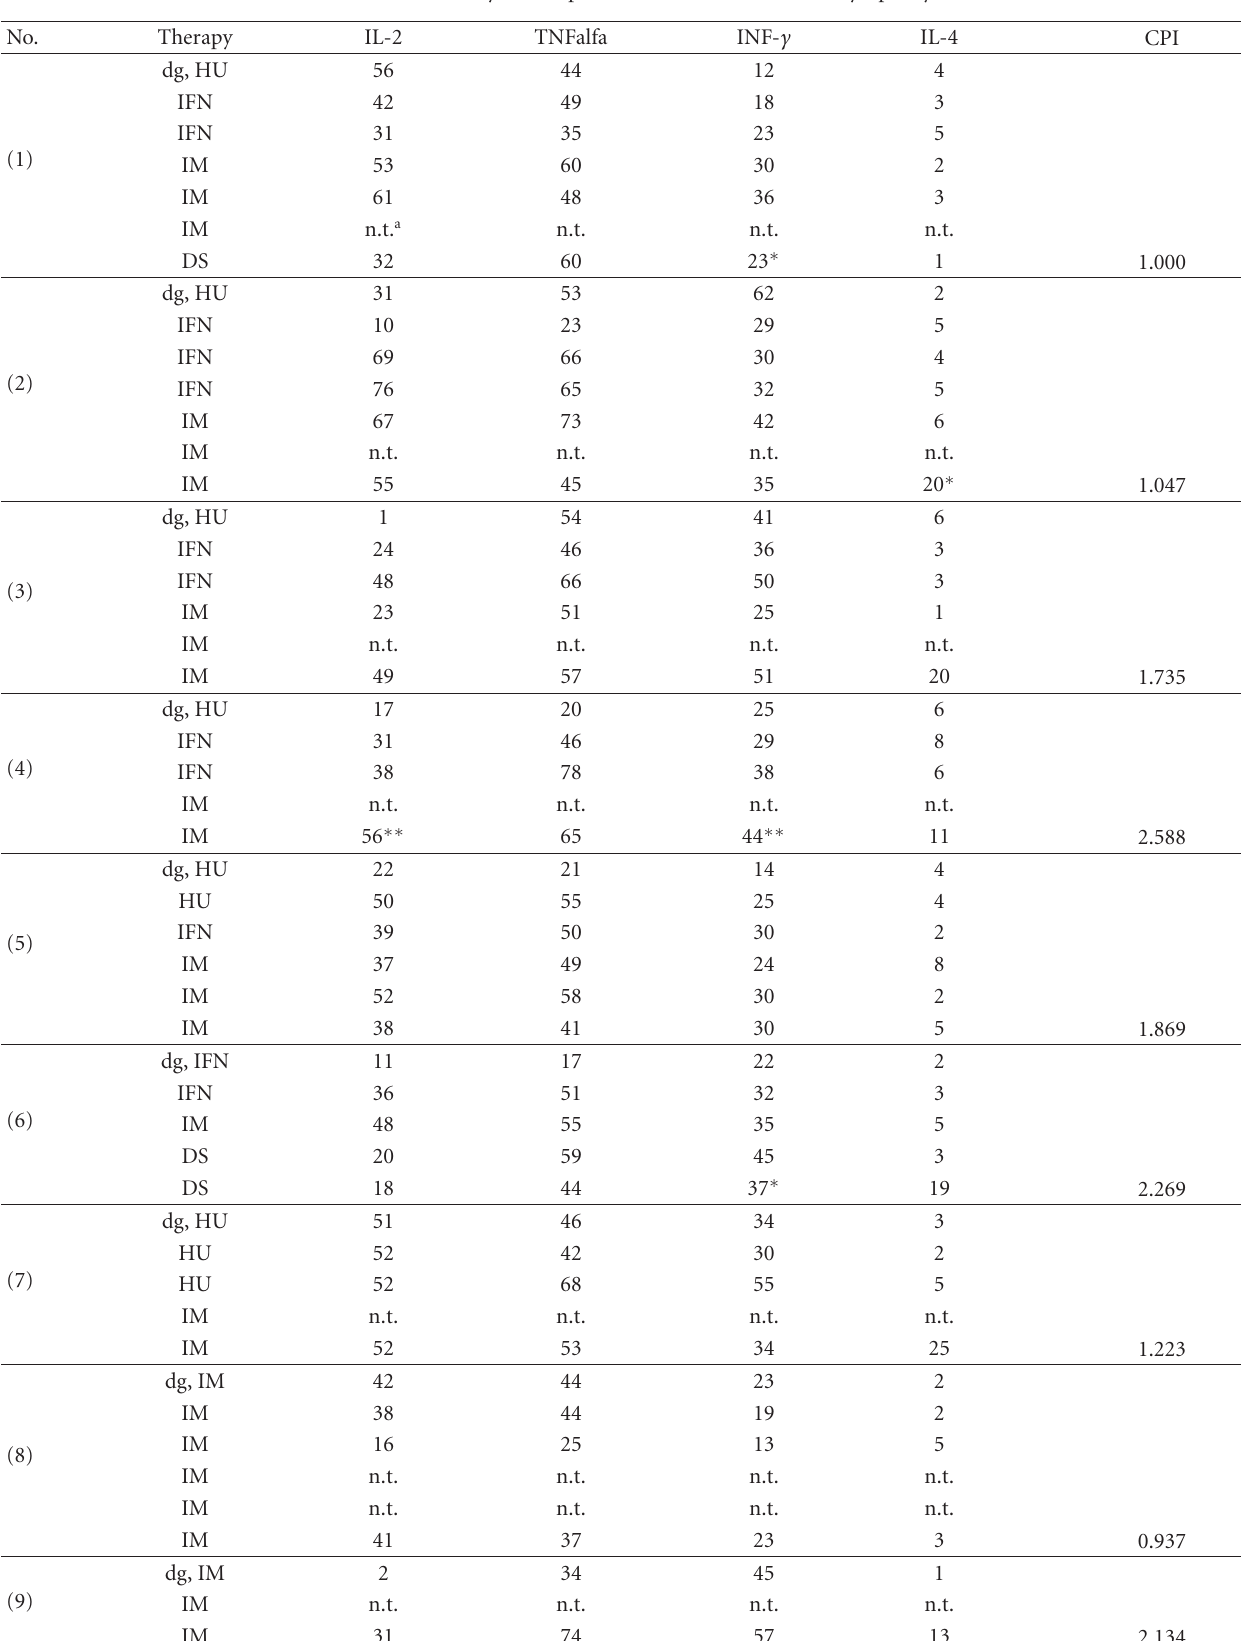
Table 6: Intracellular cytokines production in activated CD3+